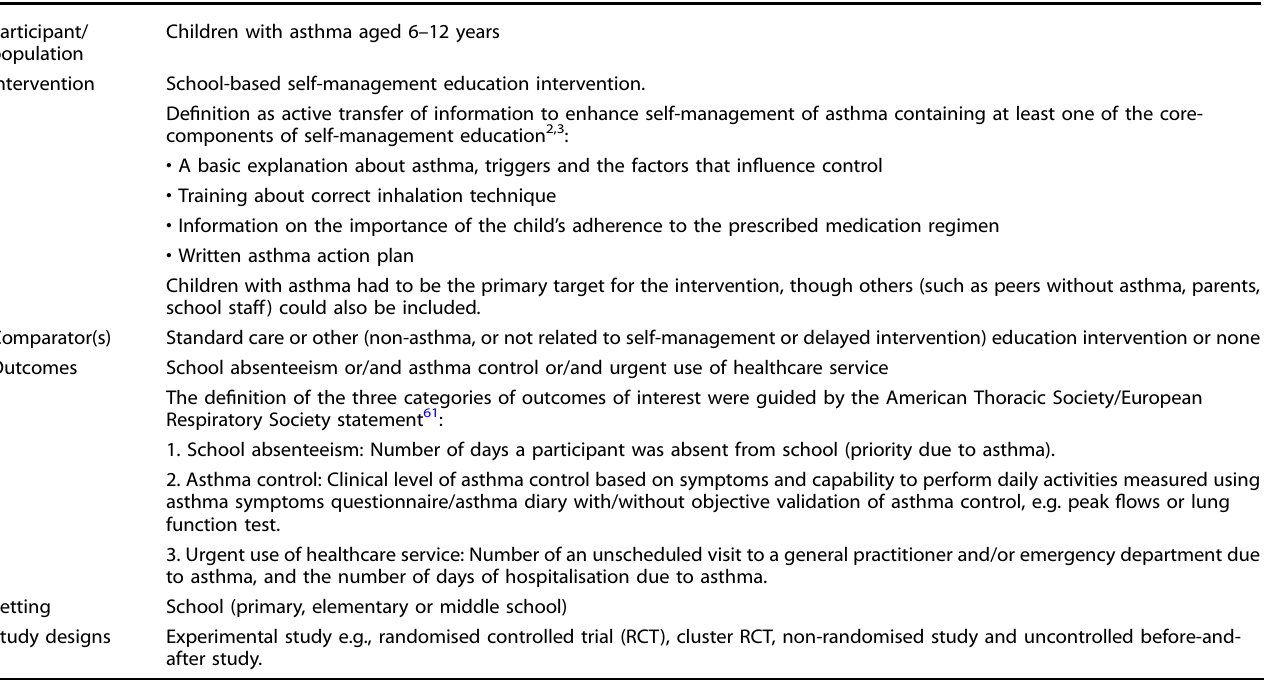
Table 3. PICO study strategy and de fi nition of terminology. Participant/